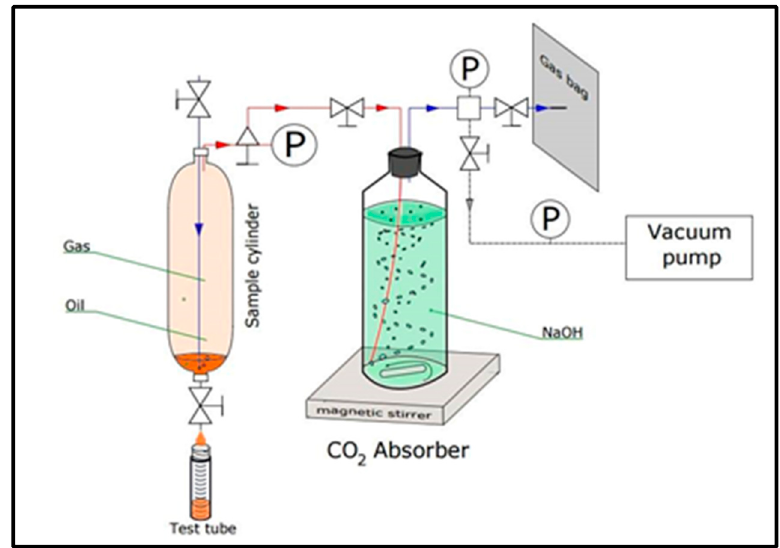
Figure 2. CO 2 absorber and gas bag system setup.